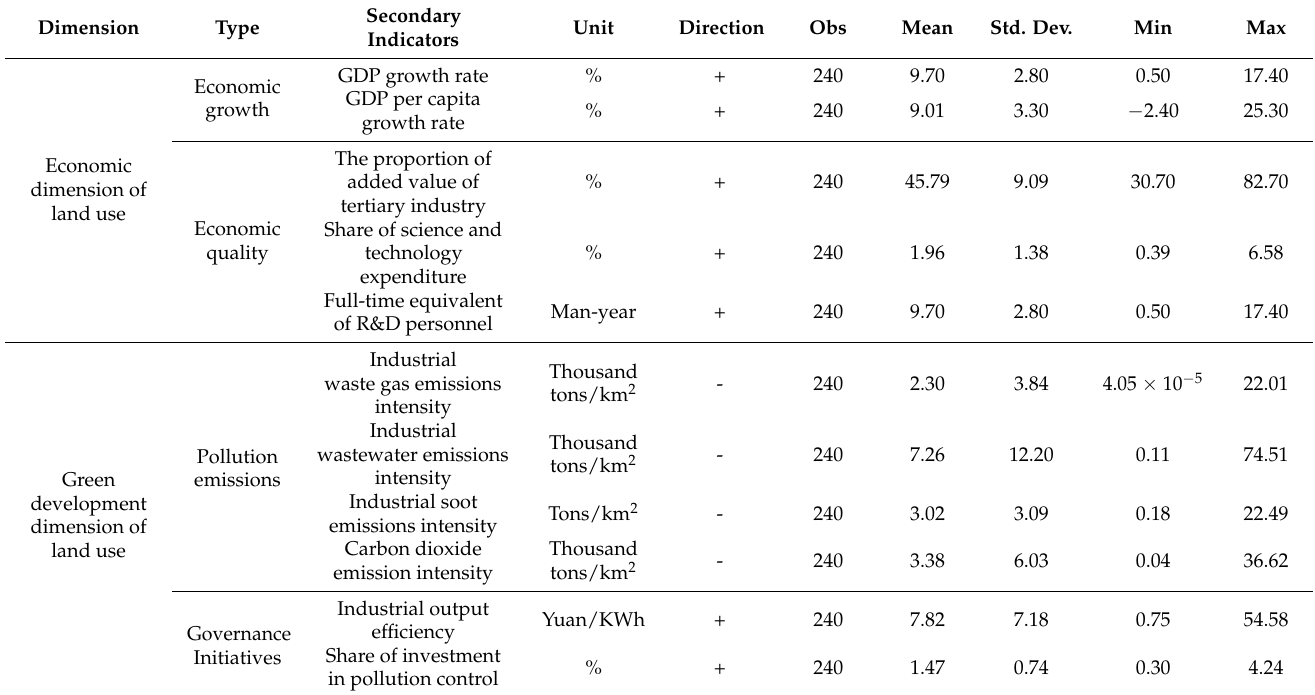
Table 1. Evaluation system of land use transition indicators under the economic and green develop- ment